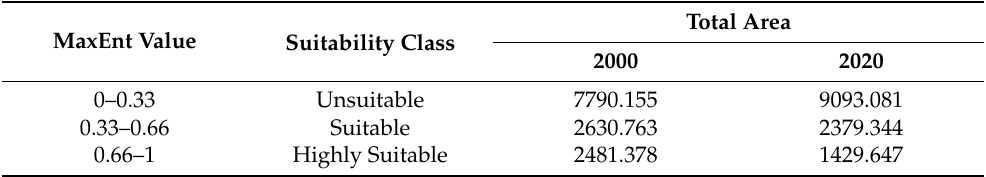
Table 6. Area of suitability for Javan leopard habitat in 2000 and